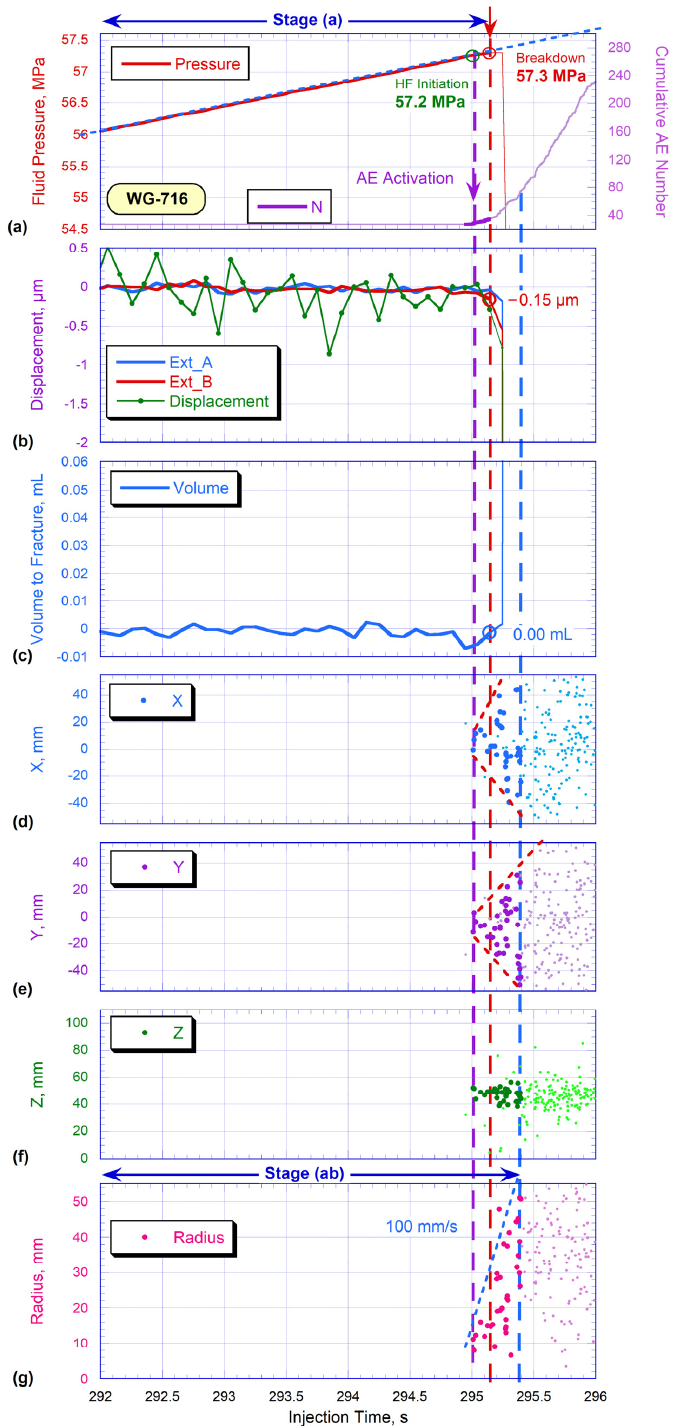
Figure 9. Sample WG-716: ( a ) fluid pressure (red) and the total number of AE signals located (purple); ( b ) axial deformations measured by the left (Ext_B, red) and right (Ext_A, blue) extensometers and a curve demonstrating loading piston position (green); ( c ) the volume of fluid injected into the hydraulic fracture; ( d , e ) horizontal coordinates of the located AE signals in the X and Y directions, respectively; ( f ) vertical coordinates of the located AE signals; ( g ) distribution of the distances between located AE signals and the axis of the sample. All parameters are plotted versus the time of sample